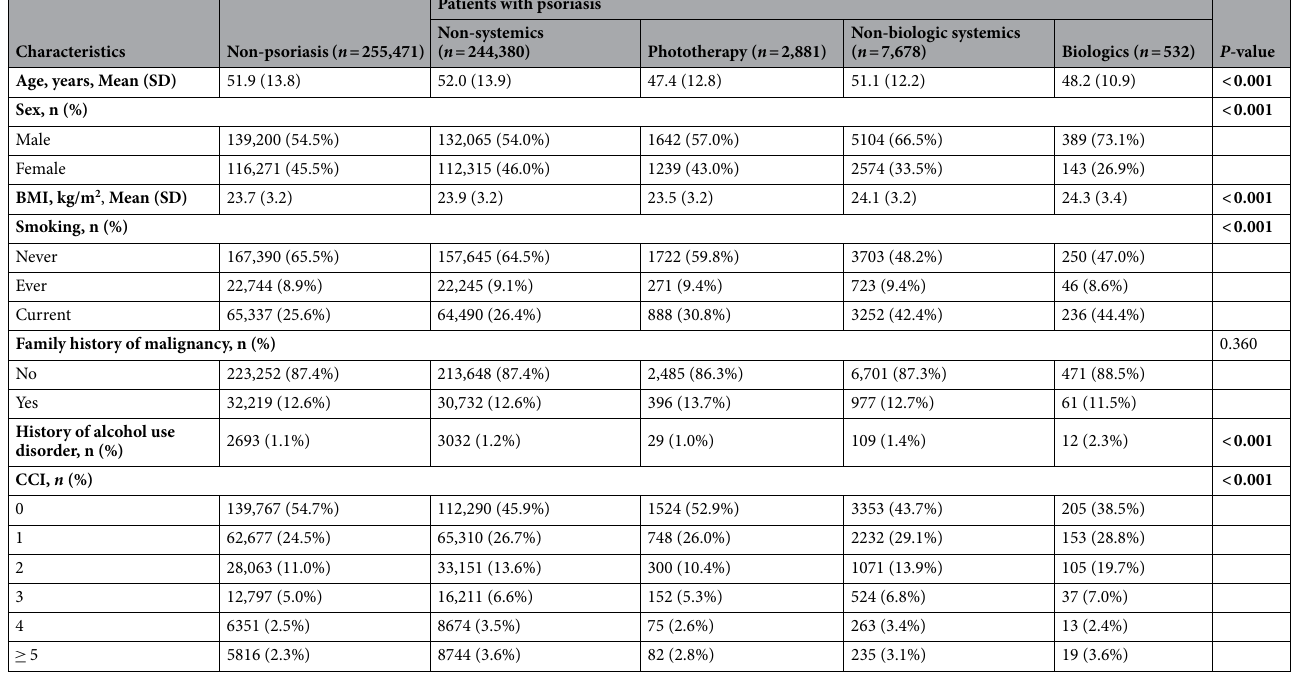
Table 1. Baseline characteristics of the study population. Significant values are in bold. BMI, body mass index; CCI, Charlson Comorbidity Index; SD, standard